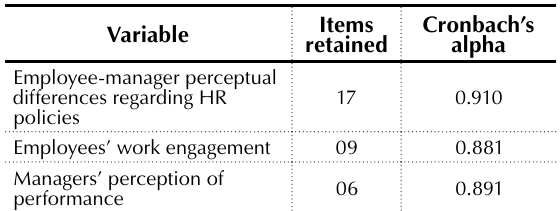
Table 2. Cronbach’s